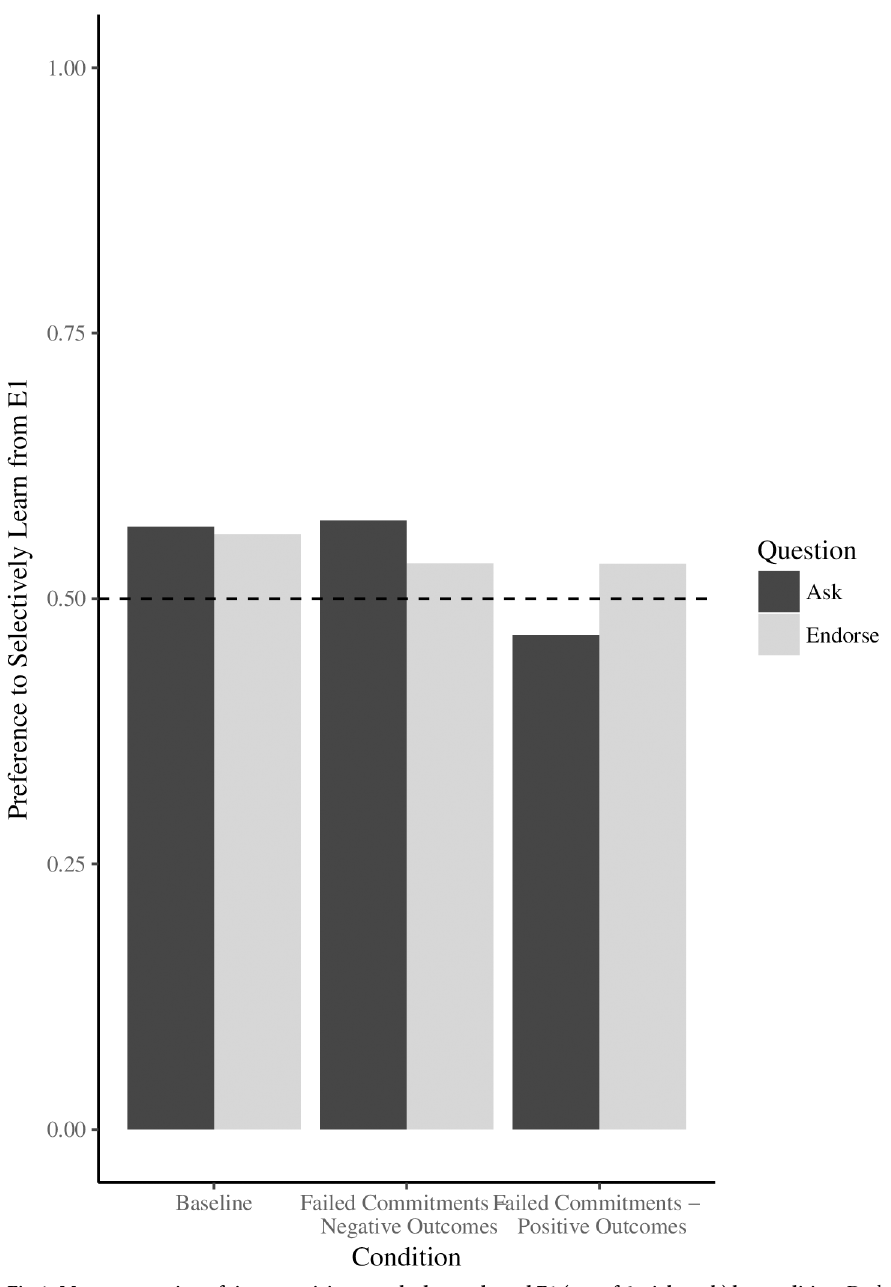
Fig 4. Mean proportion of times participants asked or endorsed E1 (out of 6 trials each) by condition. Dashed line represents chance. Error bars represent standard errors of the